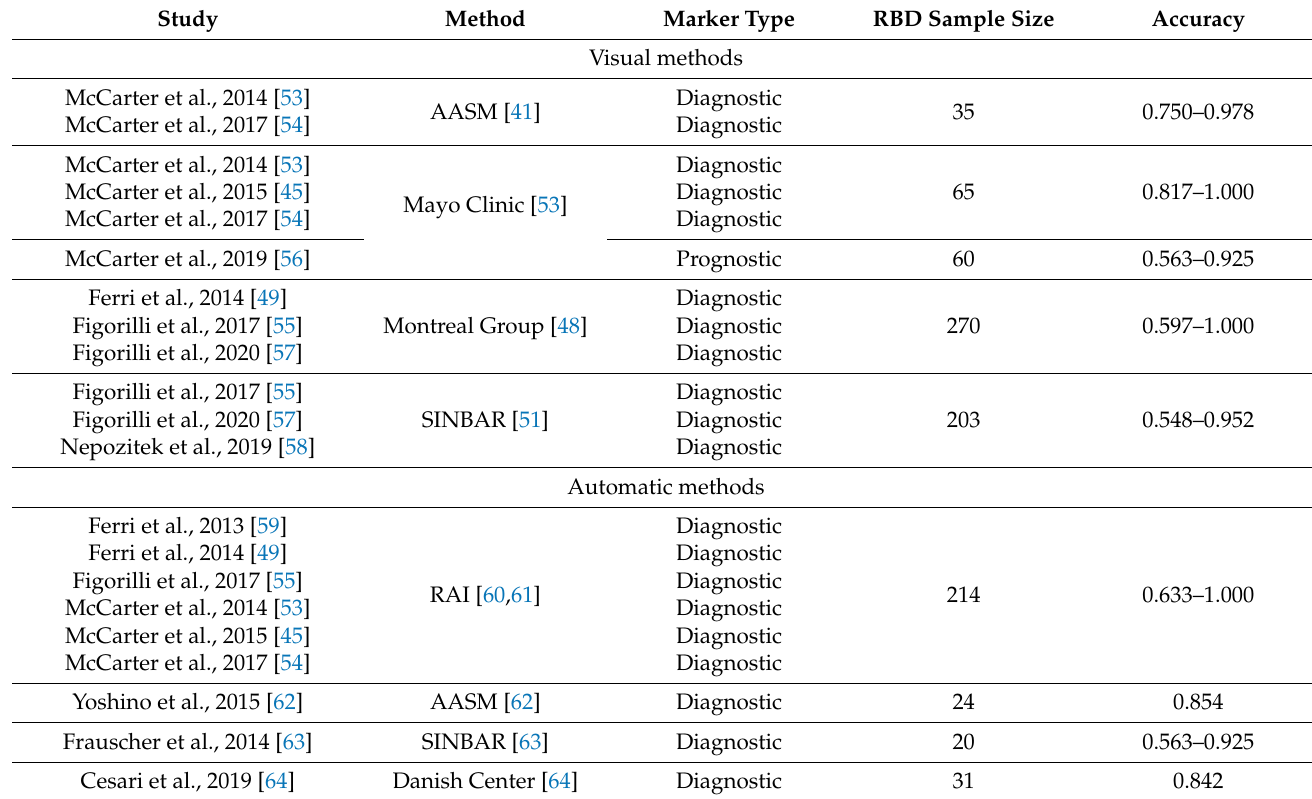
Table 1. Accuracy of some different methods (visual and automatic) for the quantification of RSWA when used for the diagnosis of